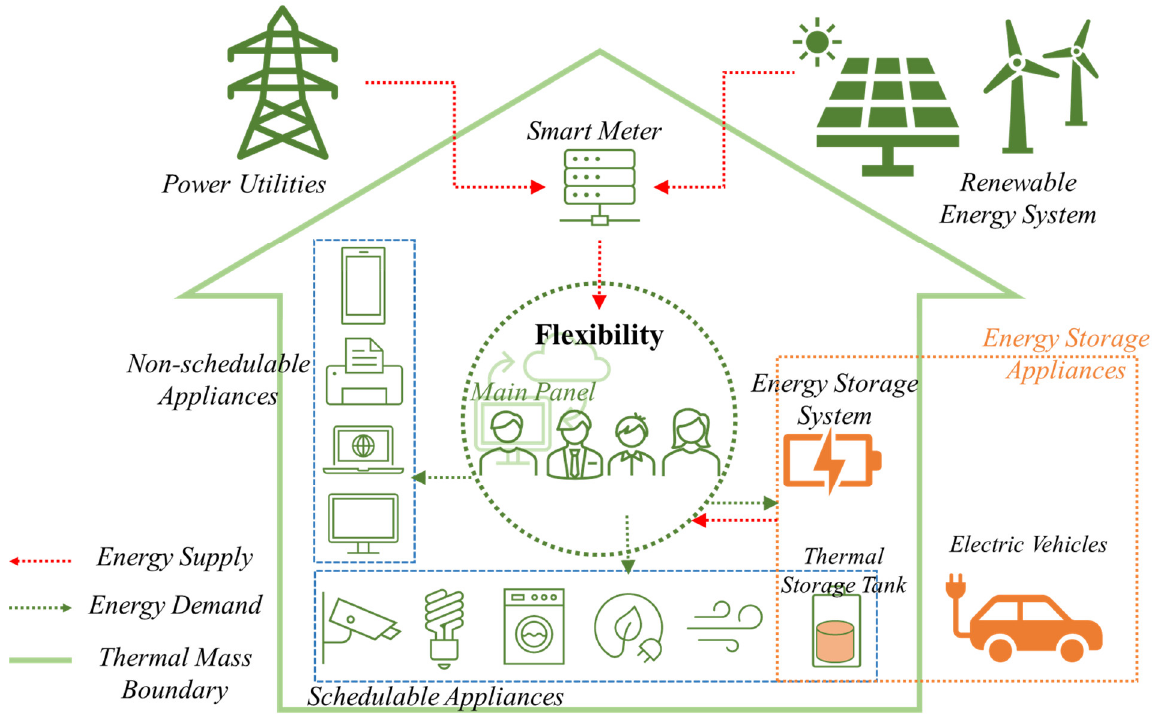
Figure 5. Energy flexibility sources of a smart home/building reprinted with permission from Ref. [66] .